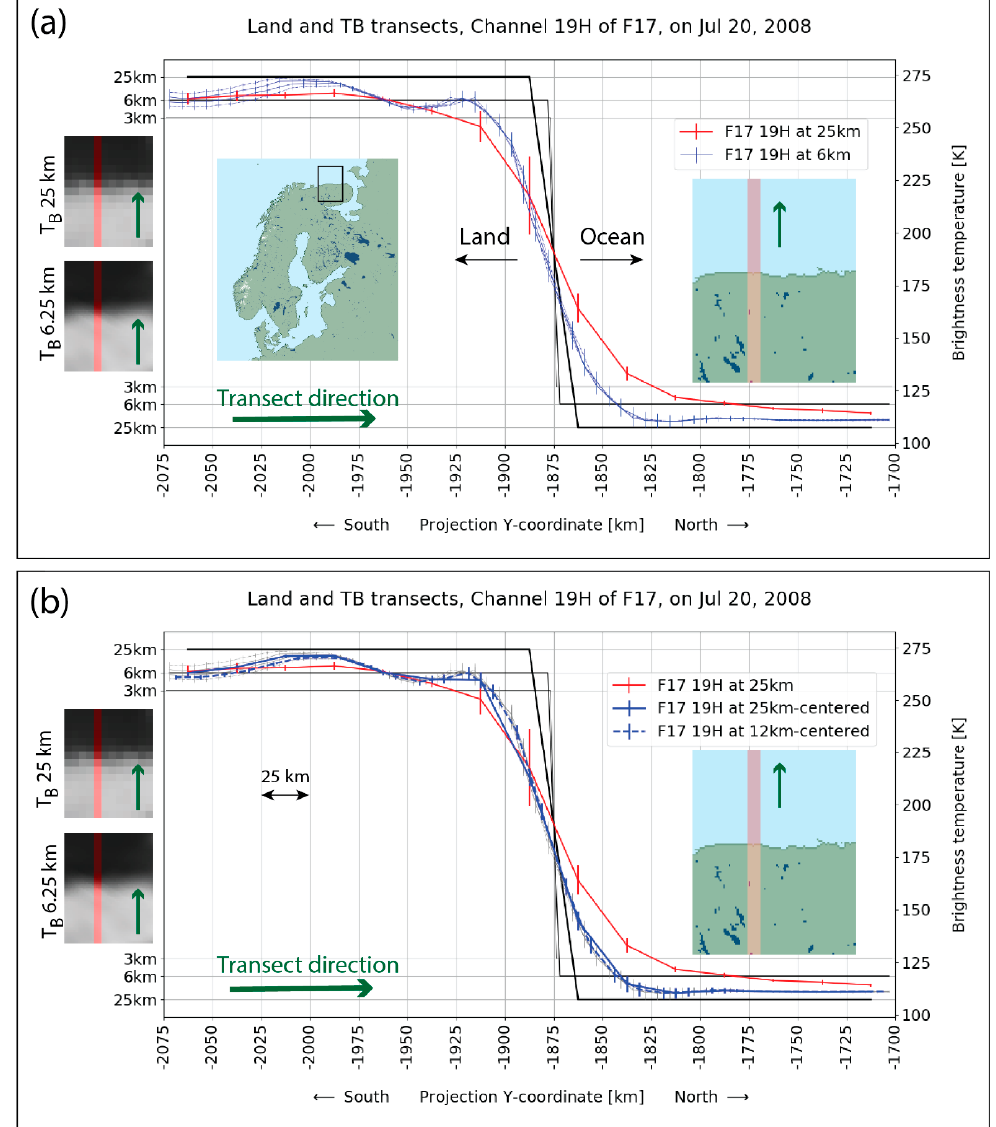
Figure 5. Transect across the land-ocean boundary, 20 July 2008. The main figure shows (a) the 19H TB (right y-axis) values for 25 km GRD (red) and 6.25 km rSIR (blue) and (b) the 19H TB values for 25 km GRD and 12.5 km and 25 km upscaled rSIR. The direction of the transect in the main figure is left (land) to right (ocean). Vertical gray lines indicate 25 km grid cells with data plotted at the center of each cell. The land-ocean boundary is at -1875 Y-coordinate. The insets on the left are TB images of the region and the insets within the main figure show the general Finnoscandian region and a close-up of the land with the overlaid transect (in pink).